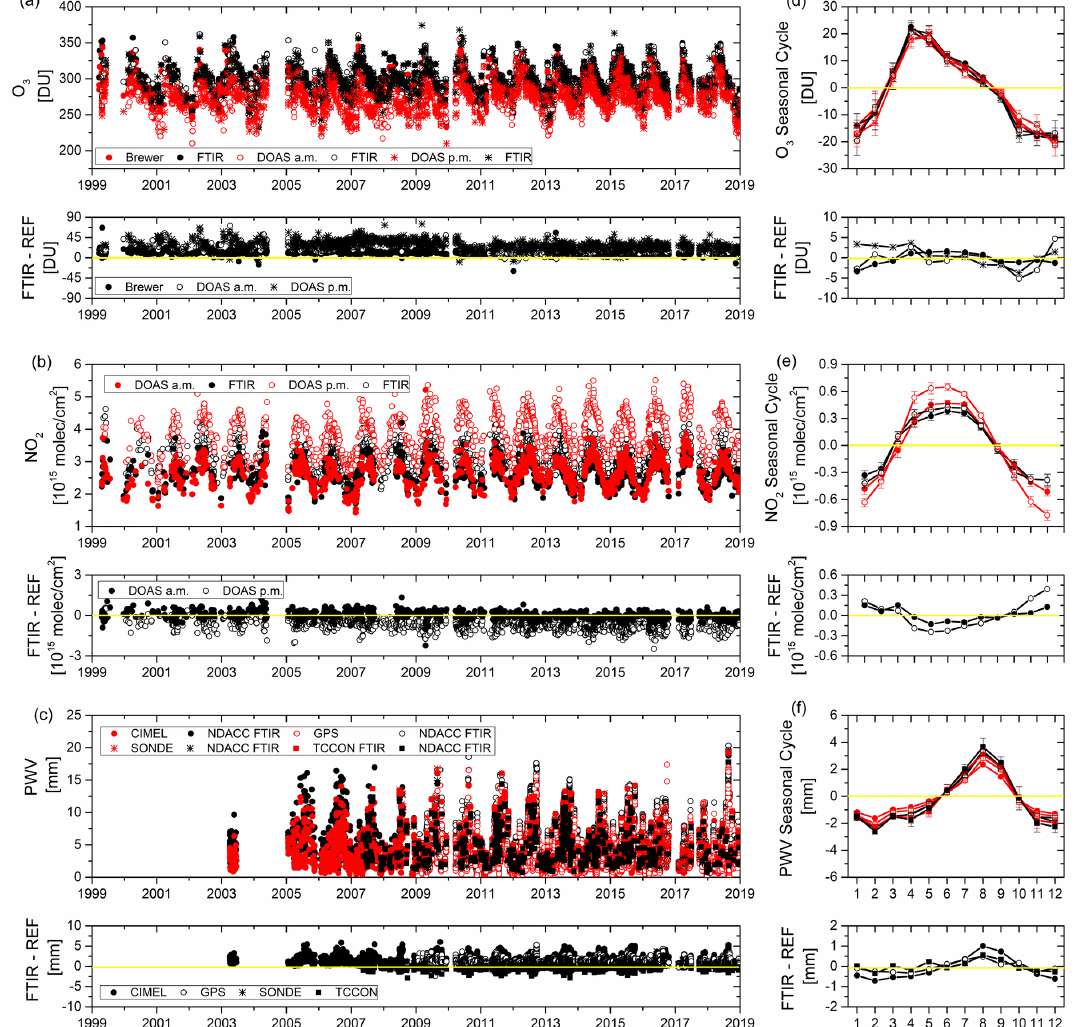
Figure 12. Time series of coincident NDACC FTIR TCs and IZO reference data sets and of differences (FTIR − reference, in absolute units) in the left panels for (a) O 3 , (b) NO 2 , and (c) PWV. Right panels show the averaged annual cycle of variations relative to the long-term background, from temporal decomposition analysis, and of differences for (d) O 3 , (e) NO 2 , and (f) PWV. Error bars in annual cycles are √ n , with σ the standard deviation and n the number of monthly measurements. The yellow line standard errors of the monthly mean: 2 × σ/ indicates the zero value (i.e. no difference or no annual cycle